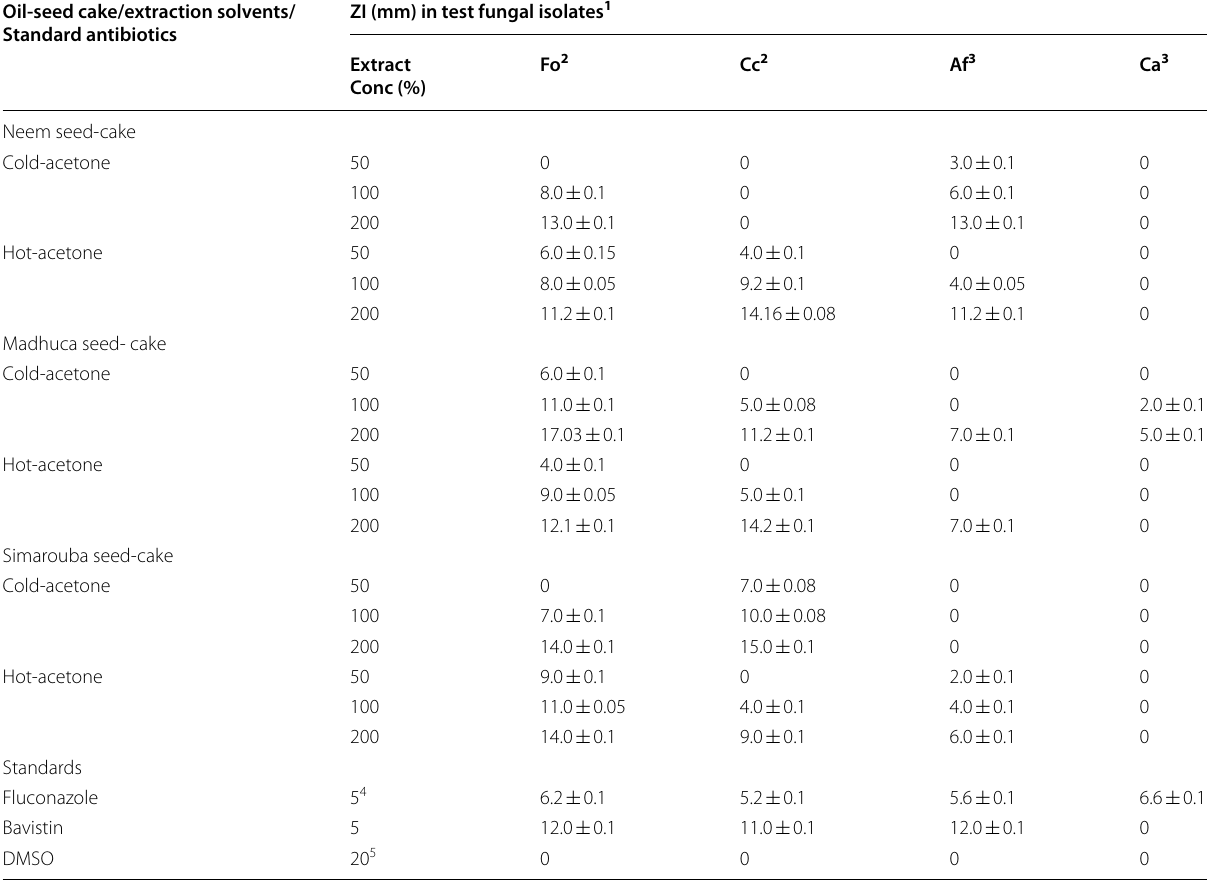
Table 2 Antifungal activity of cold and hot acetone extracts of neem, madhuca, and simarouba oil-seed